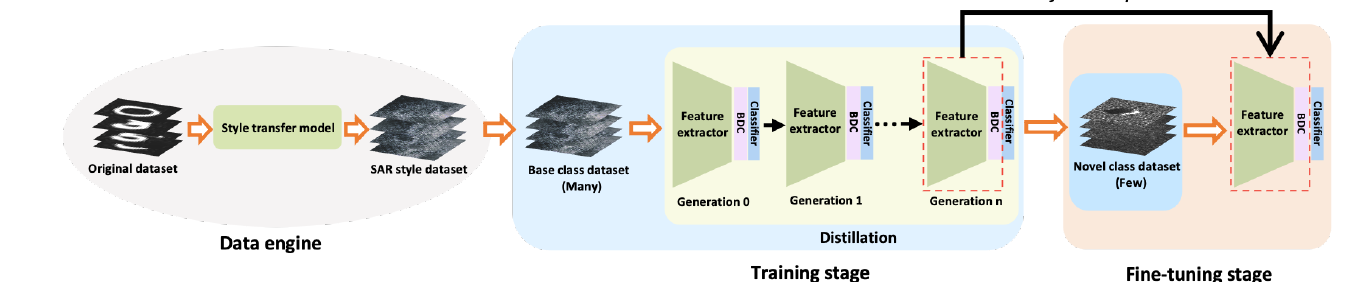
Figure 1. Framework of the proposed